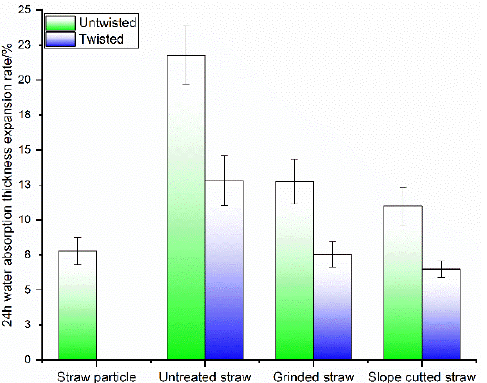
Figure 5. Thickness expansion ratio diagram of straw pellets and long straw-reinforced LLDPE composites after 24 h water absorption.